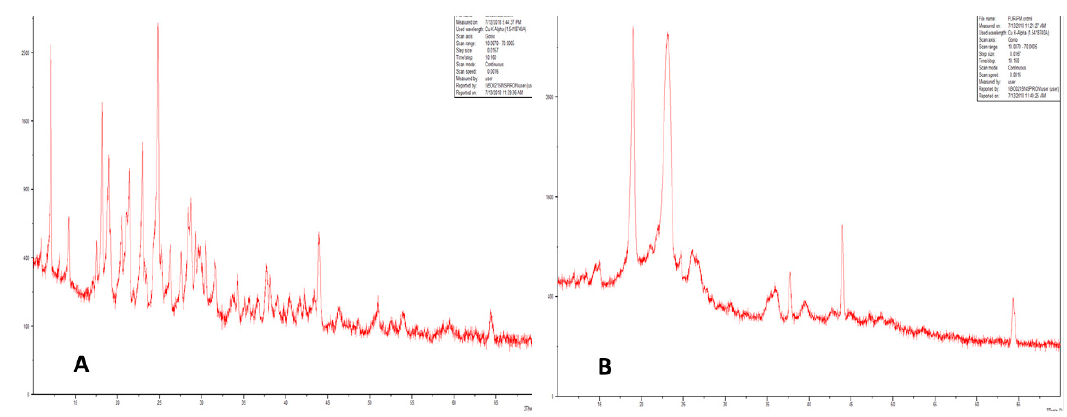
Figure 3. XRD of ( A ) furosemide and ( B ) furosemide polymersomes.